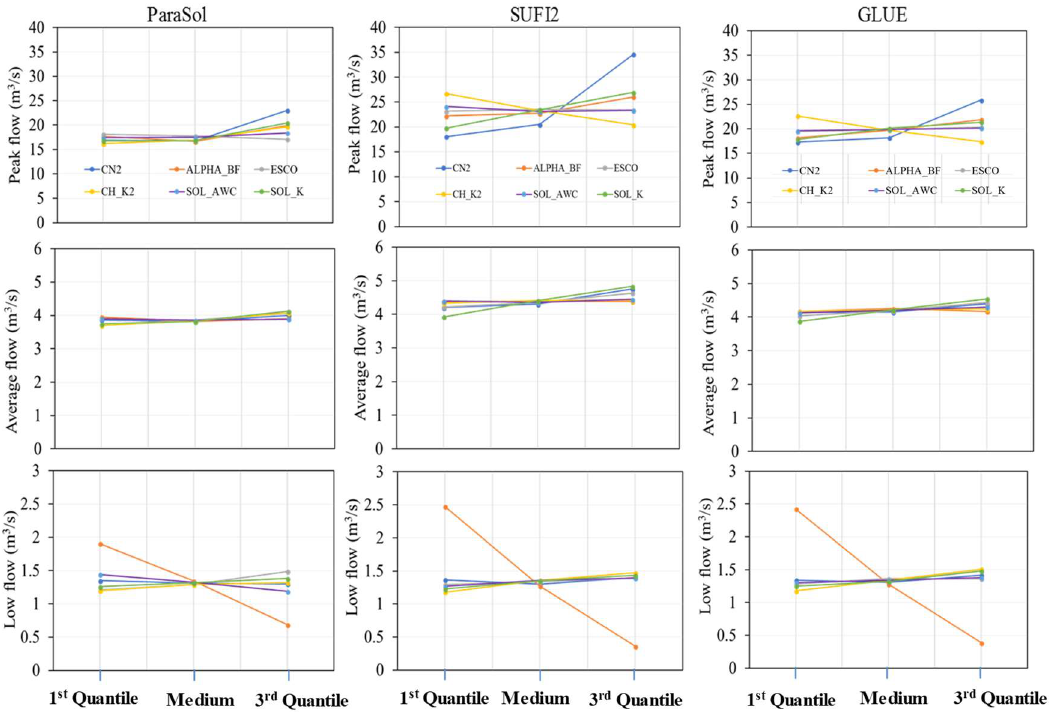
Figure 3. The effect of each parameter generated by the three methods on the peak flow, average flow, and low flow. 1st Quantile, medium, and 3rd Quantile are denoted by 25th, 50th, and 75th percentiles of the parameter distributions, respectively.